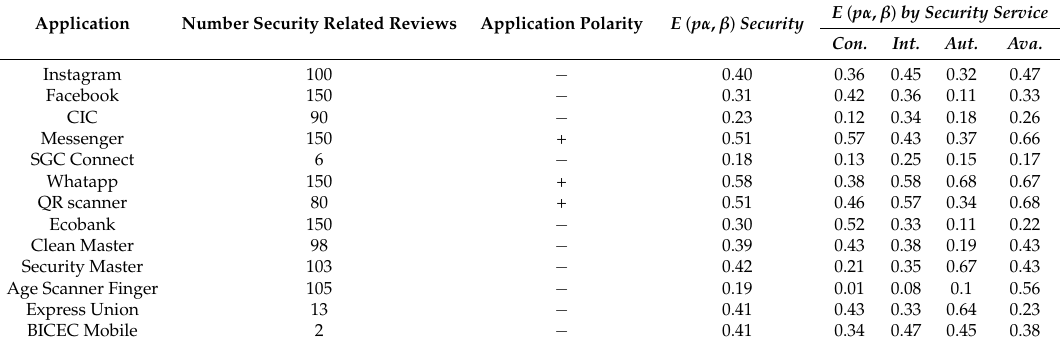
Table 5. Reputation in terms of security; ˘: negative, +: positive.